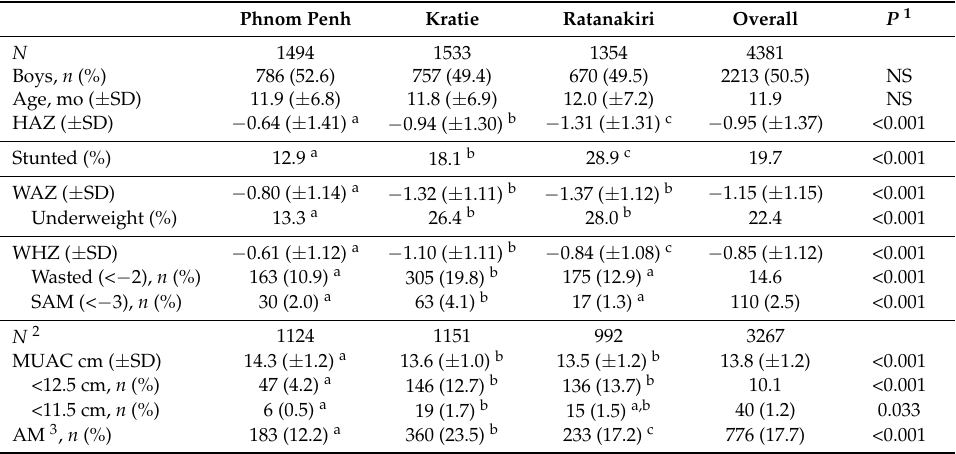
Table 1. General characteristics of the study population, by province. Phnom Penh